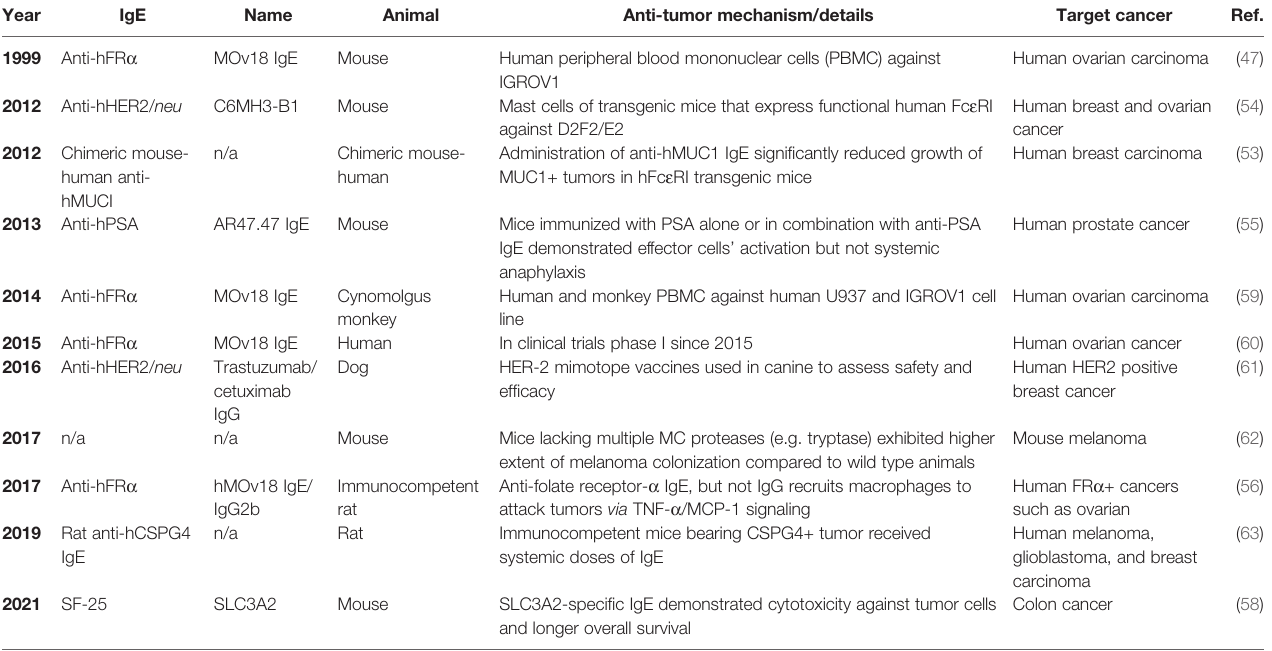
TABLE 3 | In-vivo studies of MC/IgE dependent cancer